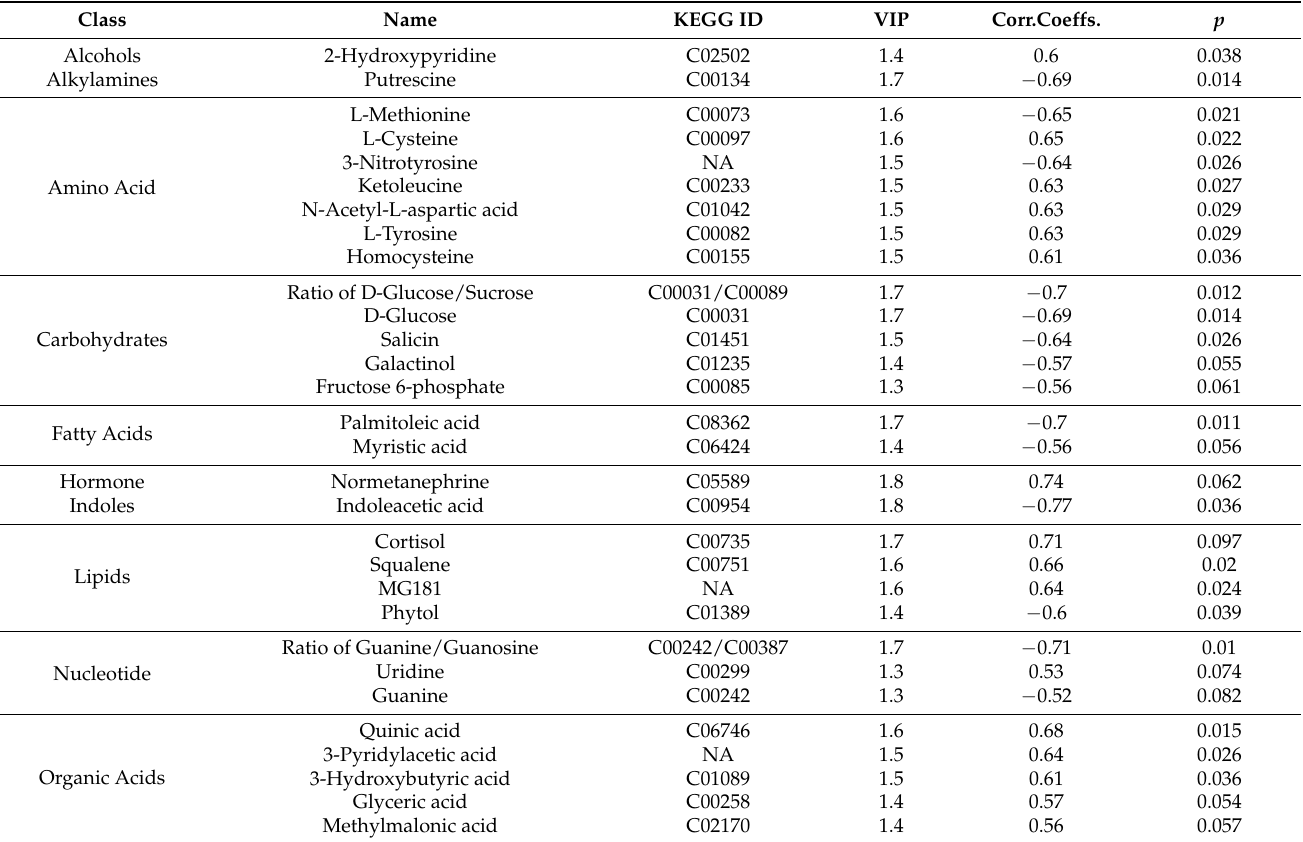
Table 1. Differential metabolites between domesticated and control populations were determined using multidimensional statistical